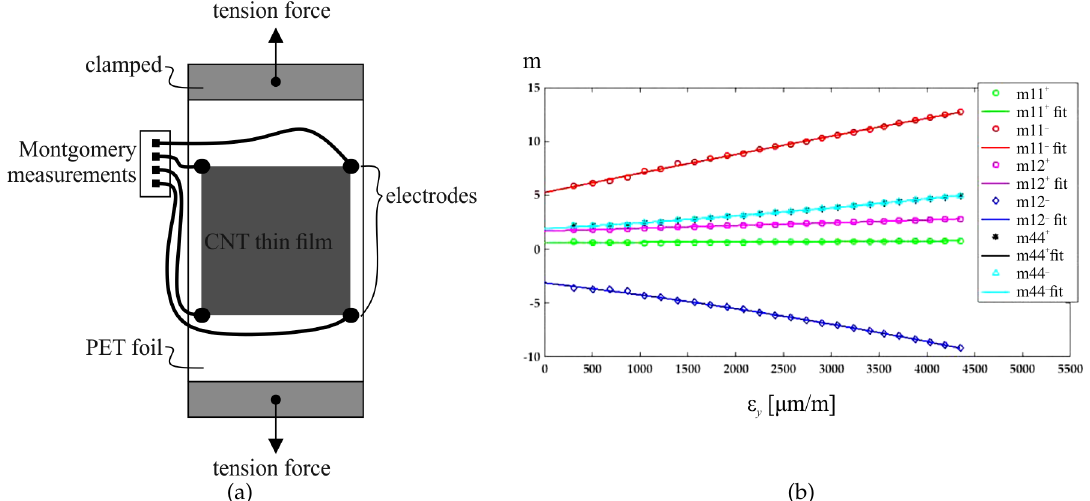
( a ) PET tension test specimen with inkjet-printed CNT embedded thin film (black) and electrode layout for data acquisition for Montgomery method. ( b ) Strain direction dependent elastoresistivity tensor coefficients ( + ) and ( − ) and fitting function over increment of tensile strain applied to the test specimen